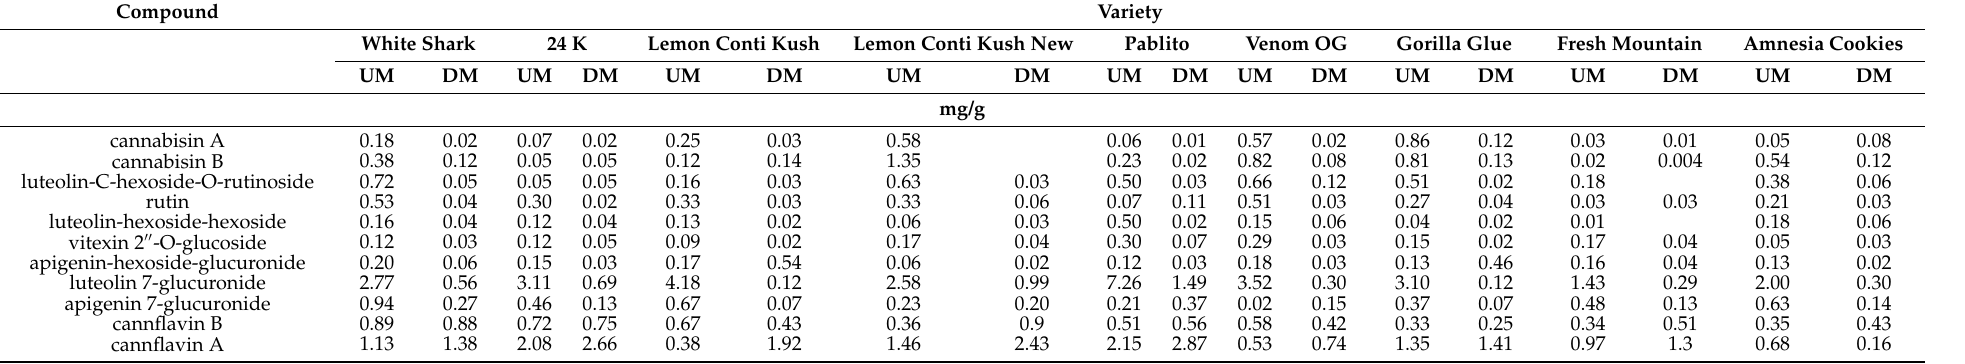
Table 7. HPLC-DAD-MS n characterization of flavonoids in UM and DM.